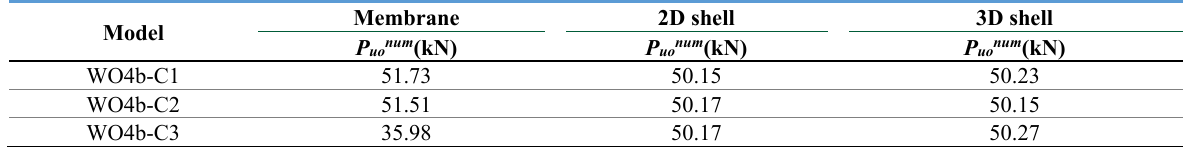
Table 7. Ultimate load results of the three approaches used to model CFRP